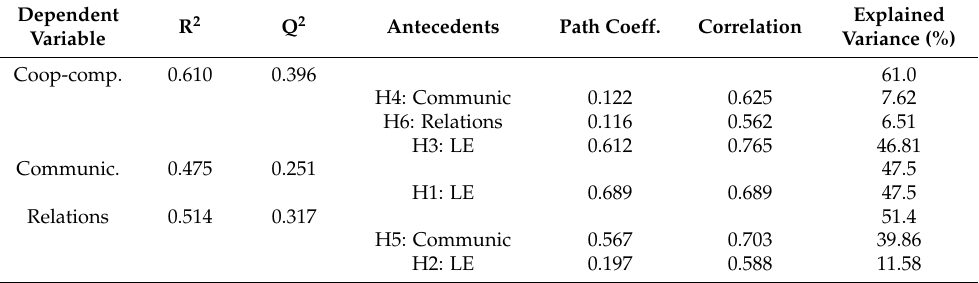
Table 6. Effects on endogenous variables (extended model).